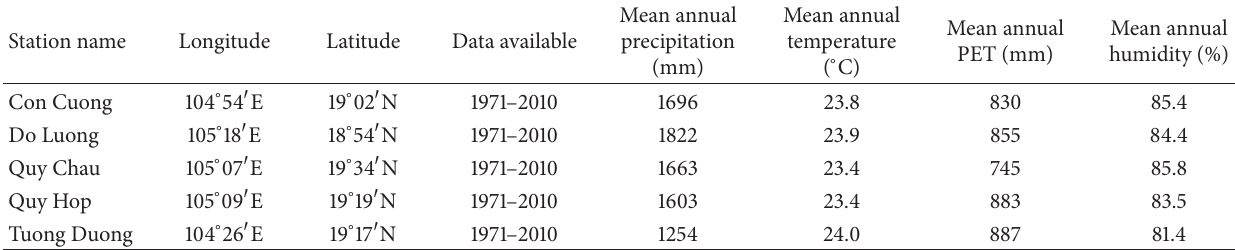
Table 2: Meteorological stations investigated in this